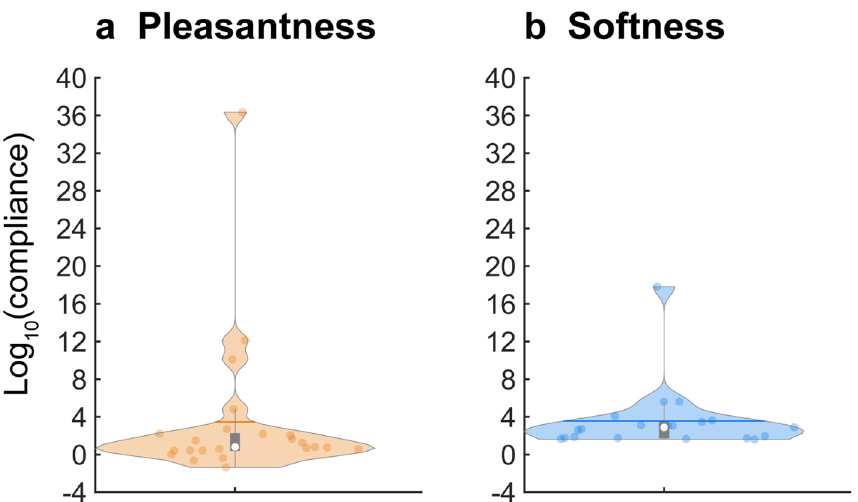
Figure 4. Distribution of compliance values providing the highest magnitude estimate. Distributions of log 10 compliance values providing the highest estimates for pleasantness ( a ) and softness ( b ) are shown as violin plots. Each dot represents the individual participant’s compliance providing the highest pleasantness ( a ) and the highest softness ( b ). The white circle, thick horizontal line, and bar indicate the median, mean, and box plot, respectively. The medians for pleasantness and softness were 0.81 (6.5 mm/N) and 2.87 (752.8 mm/N),